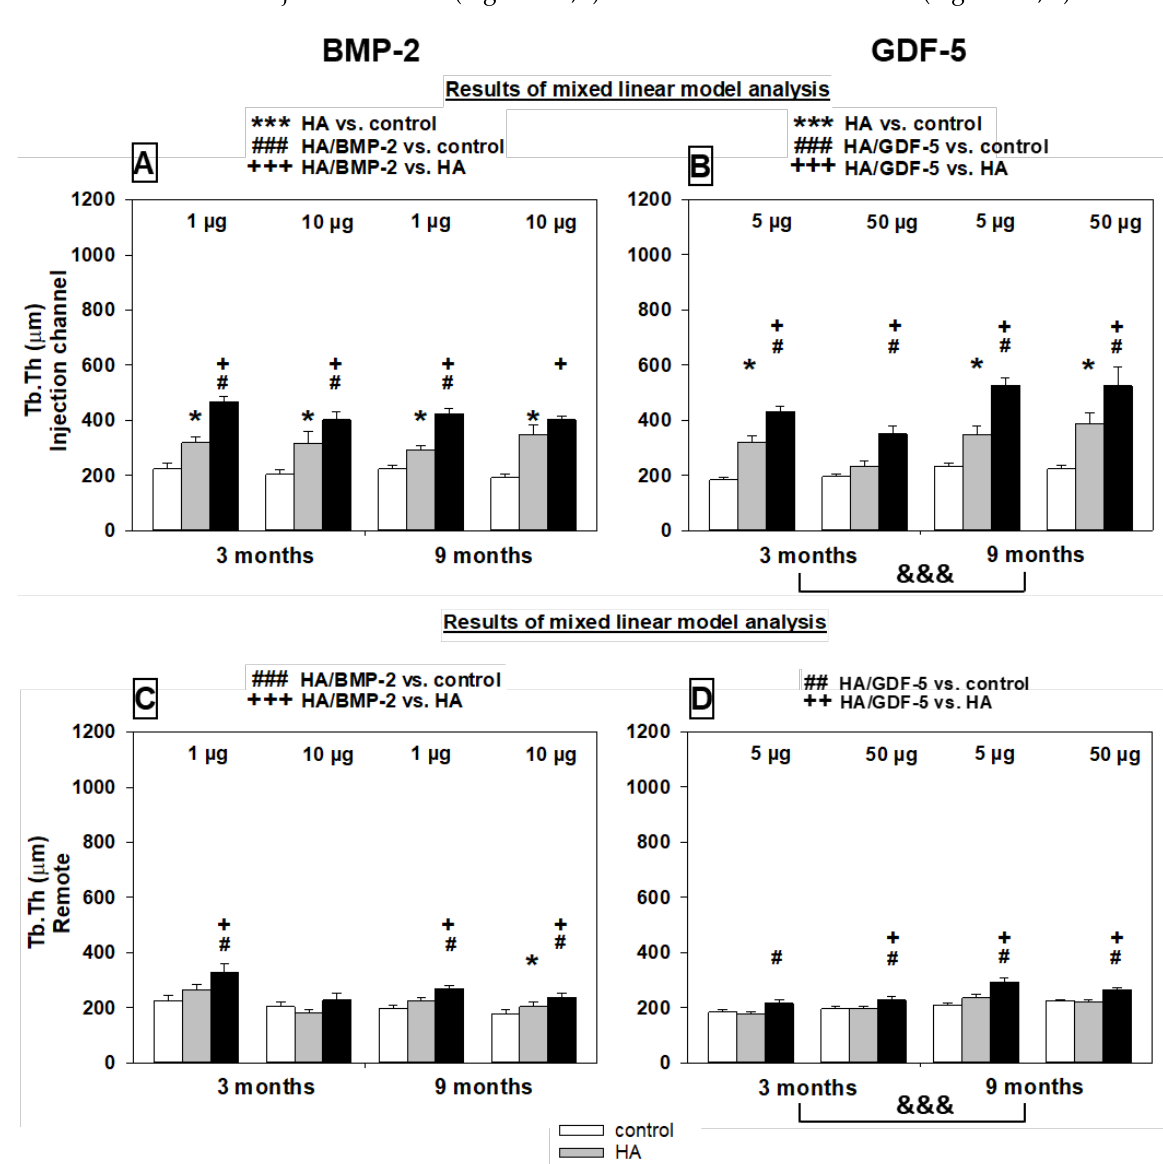
Figure 8. Increase of trabecular thickness (µm) in paraffin sections of lumbar vertebral bodies (L3 = control, L4 = HA/BMP; L5 = HA) of all investigated groups in the injection channel ( A , B ) and the remote area ( C , D ). Results of the mixed linear model analysis (compare with Tables 2 and S2); *** p < 0.001, * p ≤ 0.05 for HA compared to non-injected control; ### p < 0.001, ## p ≤ 0.01, # p ≤ 0.05 for HA/BMP compared to non-injected control; and +++ p < 0.001, ++ p ≤ 0.01, + p ≤ 0.05 for HA/BMP compared to HA; &&& p < 0.001 for 9 months compared to 3 months. Please note: The linear mixed effects model was used to analyze global effects and overall interactions of the main effects treatment (group), time point (time), BMP dose (dose), and distance from the injection channel (area); subsequently, the non-parametric multigroup Kruskal – Wallis and two-sided Wilcoxon tests were applied for the comparison of paired samples within one group, and the multigroup Friedman and two-sided Mann – Whitney U-tests for statistical evaluation of differences between groups with the above-mentioned significance levels.